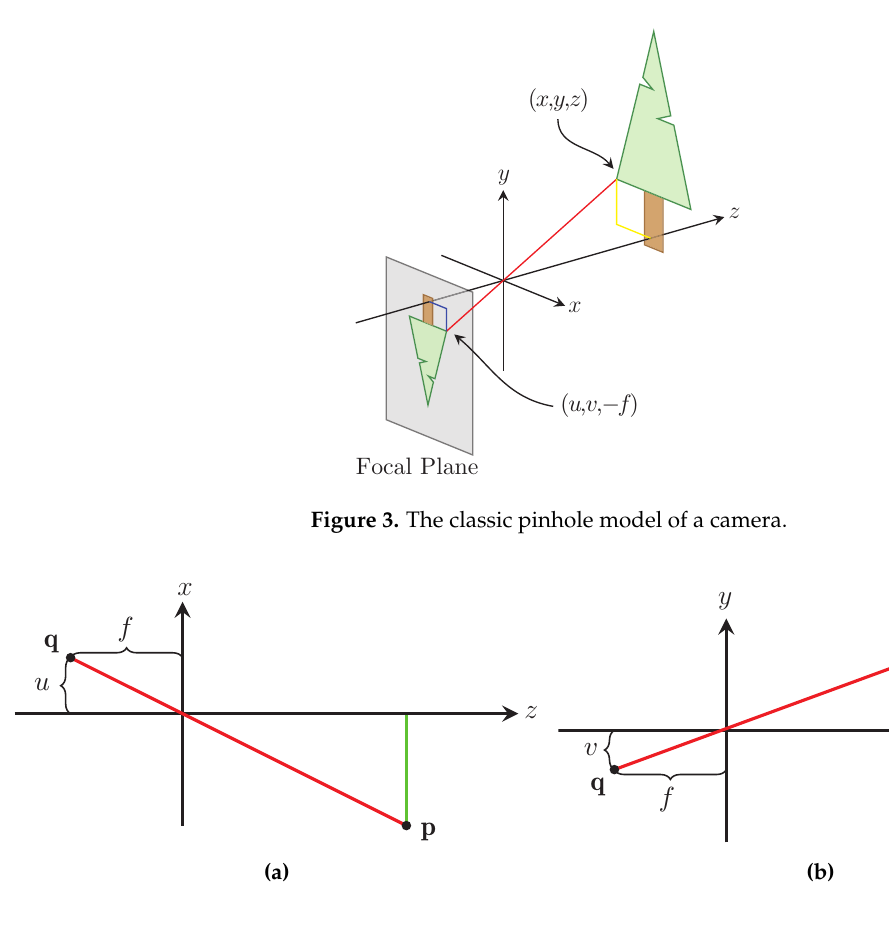
Figure 4. Projections of the classic pinhole camera model in the xz plane ( a ) and the yz plane ( b ).